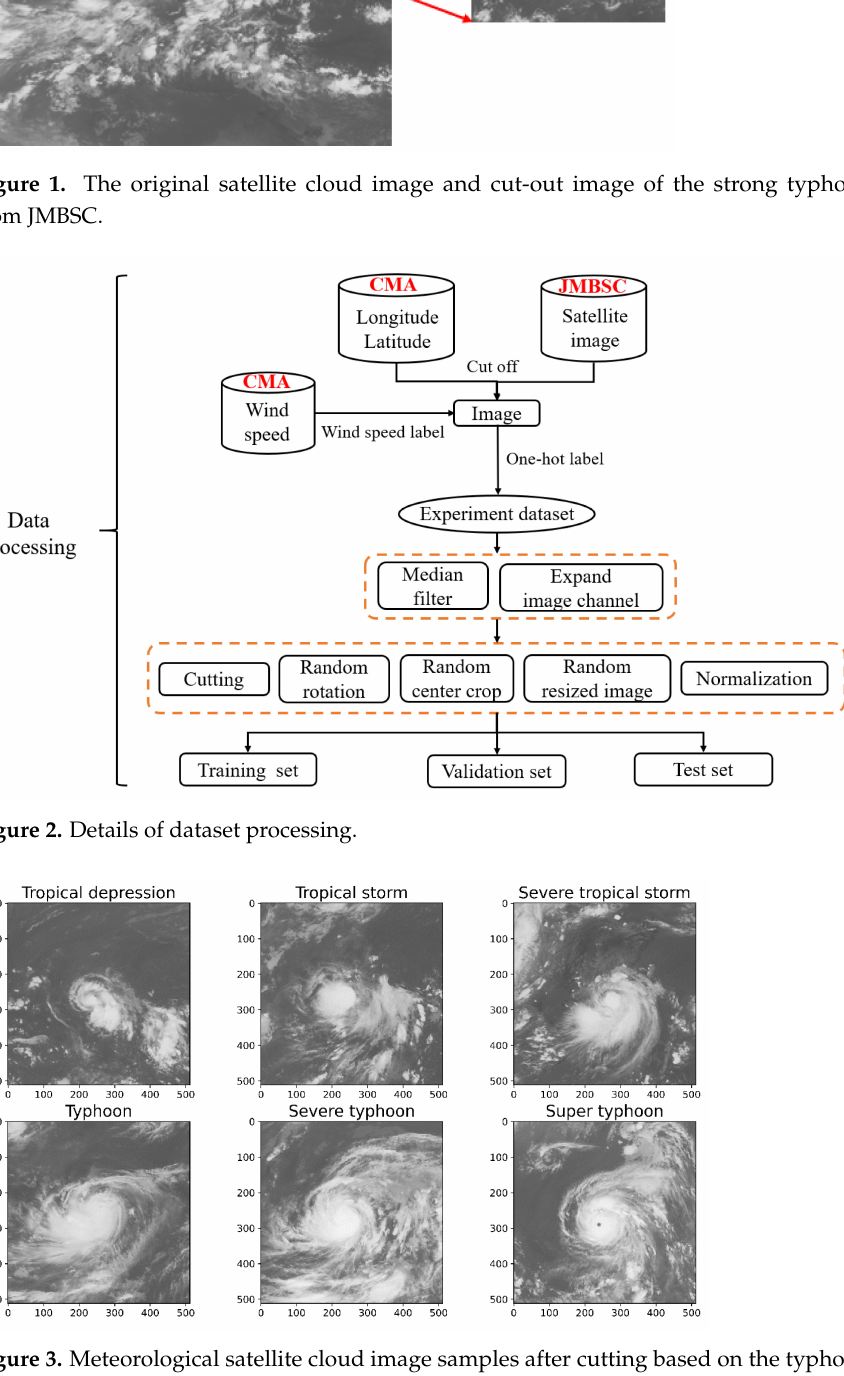
Figure 3. Meteorological satellite cloud image samples after cutting based on the typhoon location for six TC